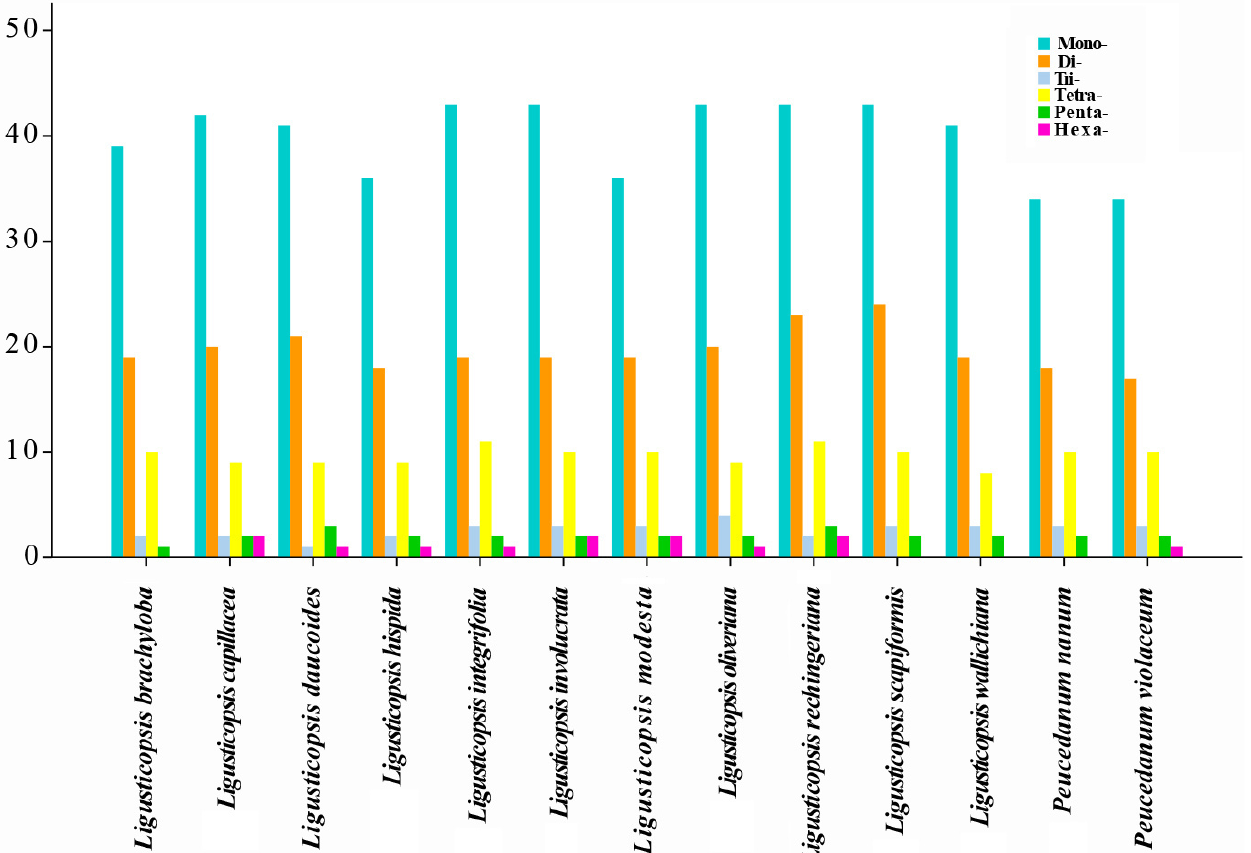
Figure 4. The different repeat types identified in thirteen plastomes.